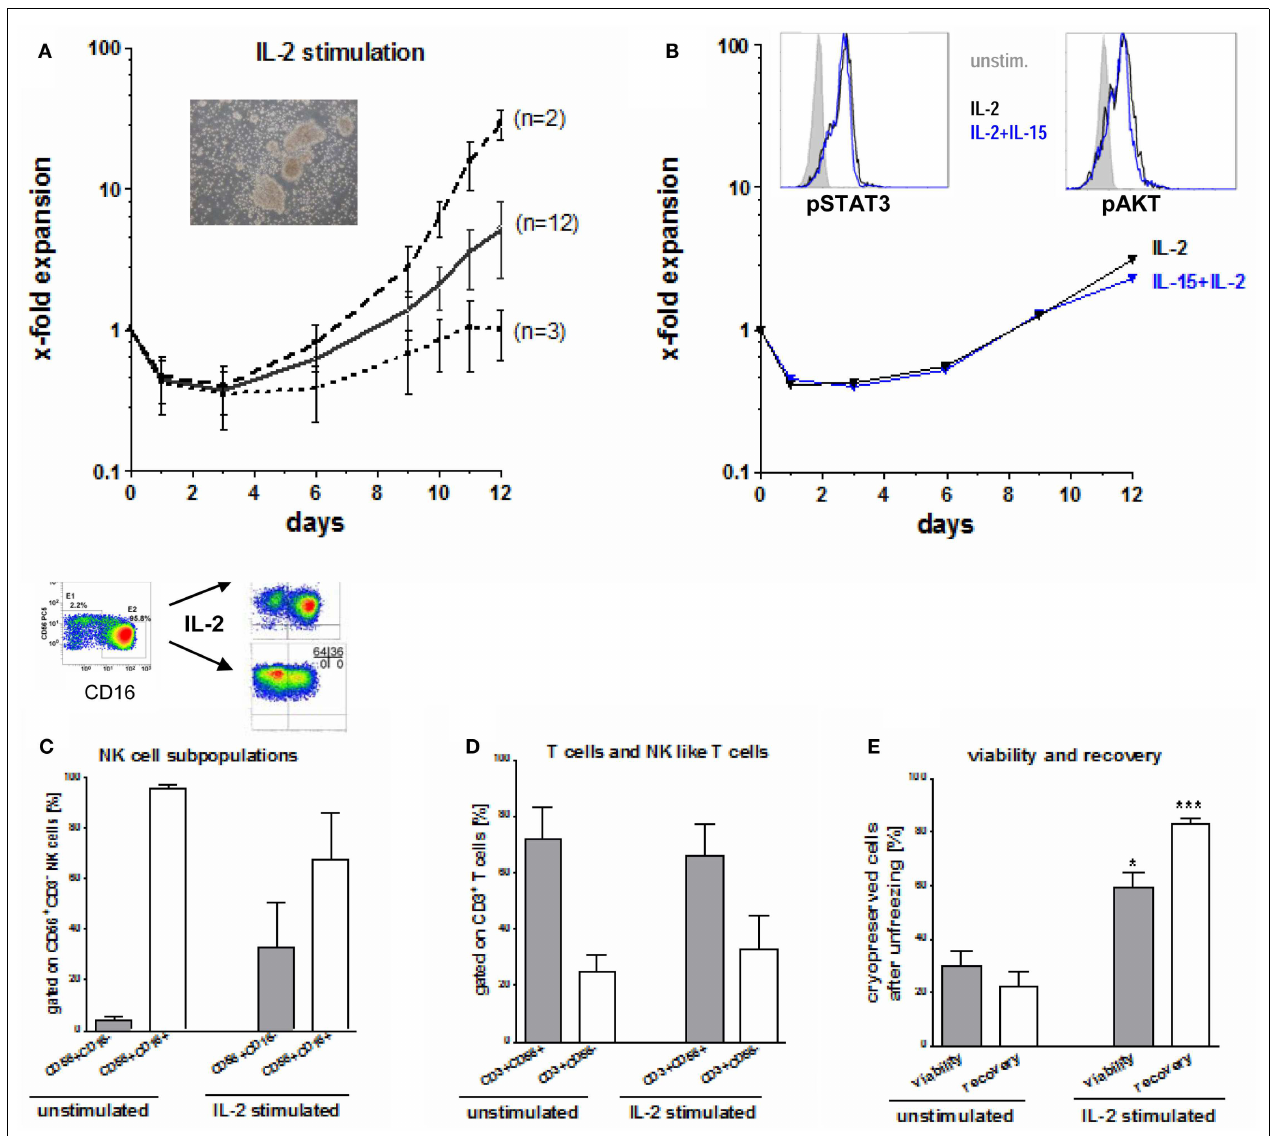
activation. (C) Although the major cytotoxic CD56 dim CD16 pos and the minor immunoregulatory CD56 bright CD16 neg NK subpopulation showed a homogeneous distribution after NK cell enrichment, this changed during IL-2 stimulation. After activation large differences between CD16 pos and CD16 neg NK subpopulations were seen among the NK cells of various donors. (D) After NK cell purification residualT cells consists of 3/4 of CD3 + CD56 + NK likeT cells and of 1/4 CD3 + CD56 − T cells, a ratio which changed only slightly during IL-2 stimulation. (E) Both, viability and recovery was higher after unfreezing of Il-2 stimulated compared to unstimulated NK cells and was highly significant for the NK cell recovery.